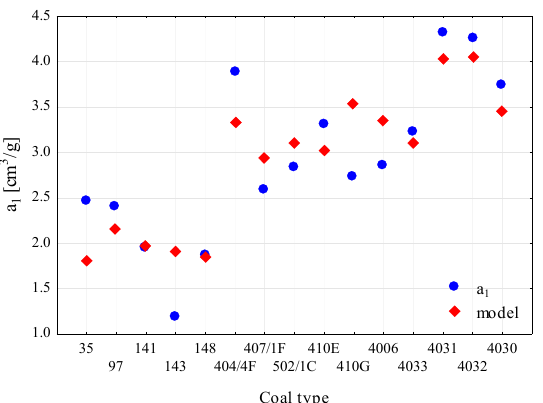
Figure 10. Value comparison between the sorption capacity under set pressure a 1 with the created regression model (Equation (11)).